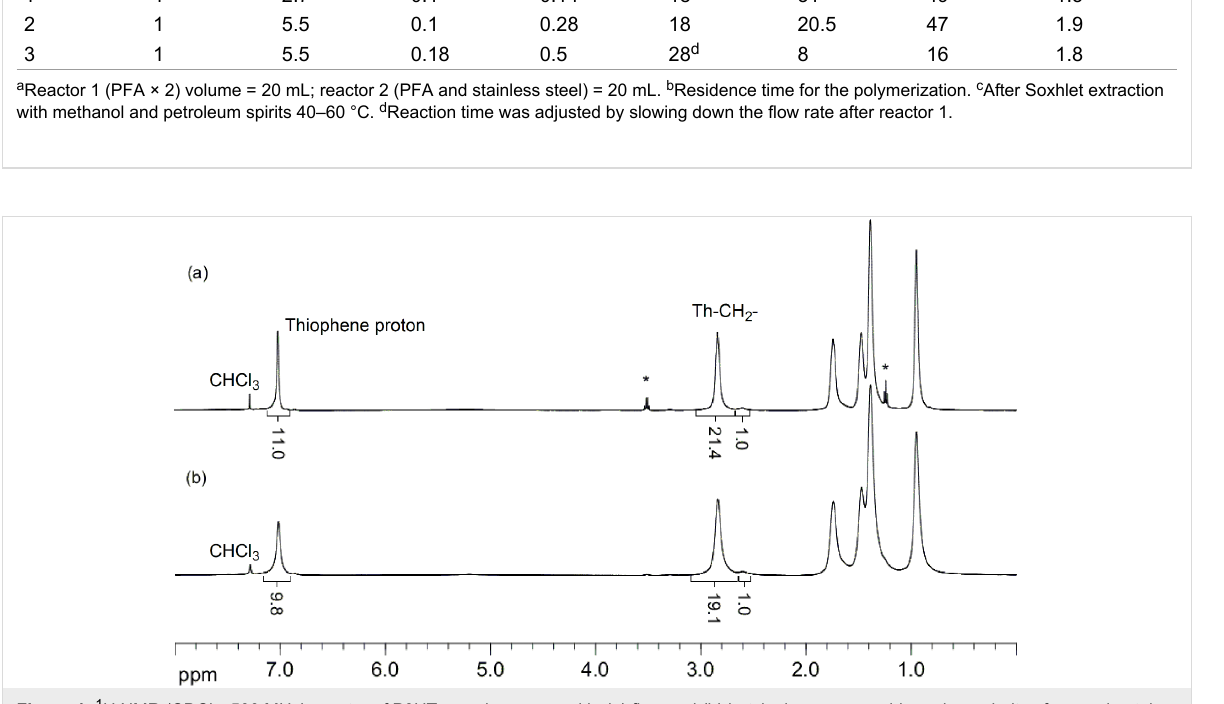
Table 3: Data for the telescoped synthesis of P3HT from 2,5-dibromo-3-hexylthiophene ( 1 ) in flow. a Entry